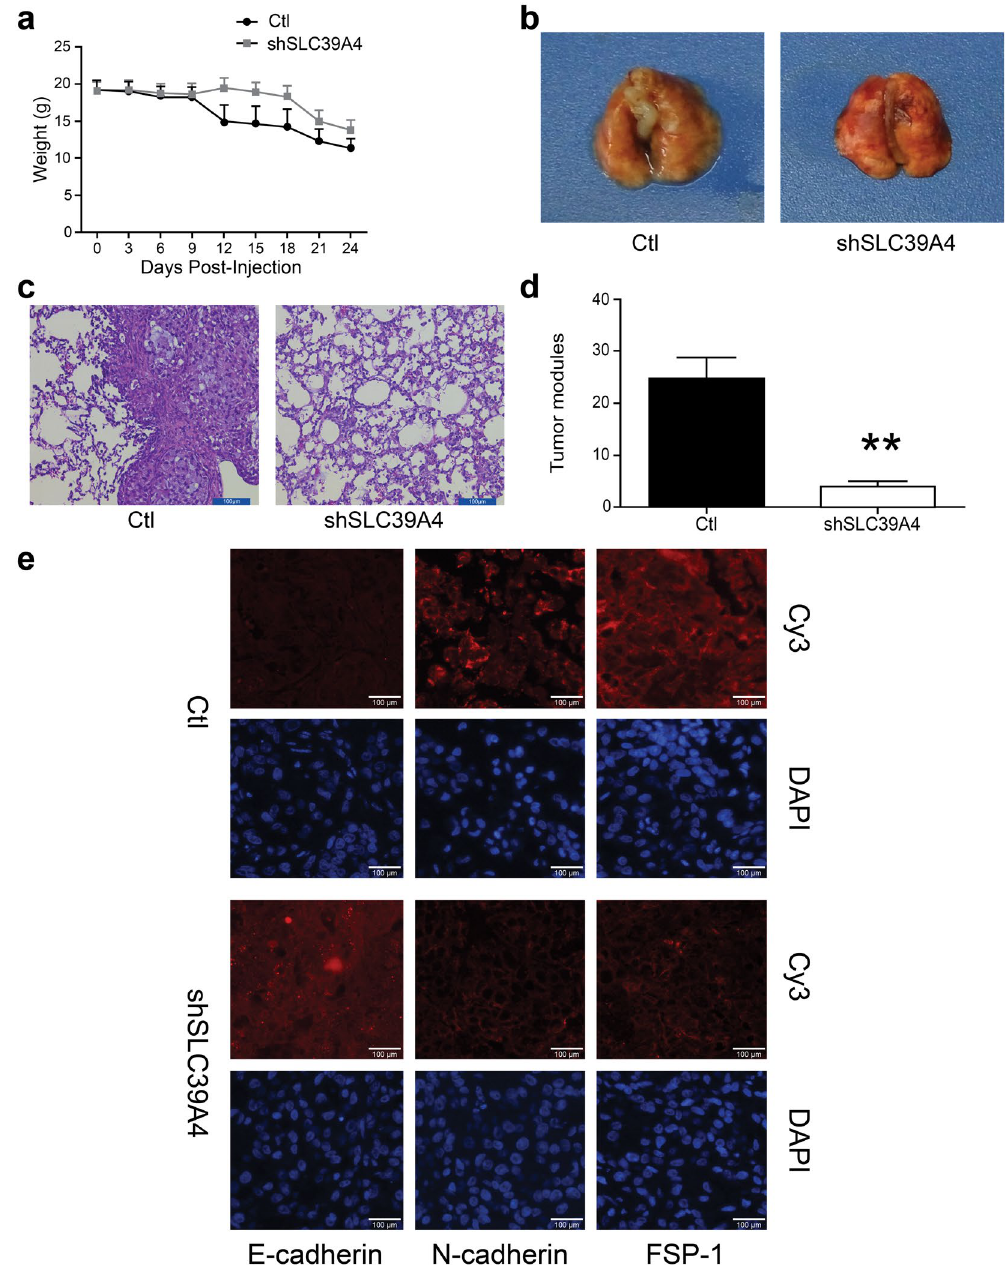
Figure 4. SLC39A4 silencing limits metastatic spread in a mouse model of lung cancer. ( a ) Body weight measurements of tumour-bearing mice. ( b ) Representative images of mouse lungs 30 d after shSLC39A4 or Ctl A549 cell engraftment. ( c ) Representative images of H&E staining in lung tissue sections from each group (scale bar, 100 μ m). ( d ) The average number of metastatic tumour nodules in the lungs xenograft mice. E. Immunofluorescence for E-cadherin, FSP-1, and N-cadherin expression in A549 shSLC39A4 or Ctl subcutaneous tumours (scale bar, 100 μ